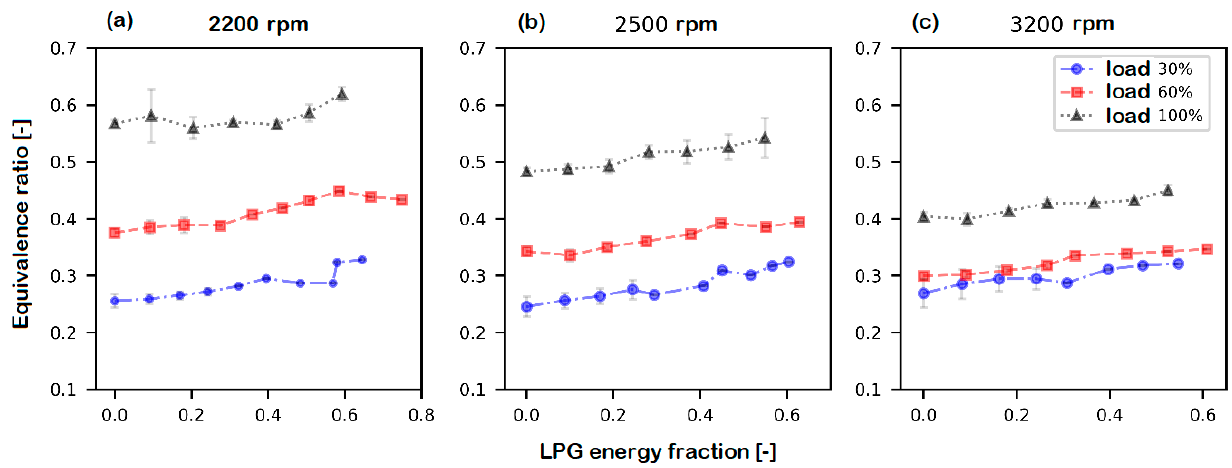
Figure 6. Equivalence ratio v/s LPG energy fraction at ( a ) 2200 rpm, ( b ) 2500 rpm, and ( c ) 3200 rpm. Table 3 highlights the most important findings for PDr, Bfce and diesel fuel substitution for dual Table 3. Most important findings for PDr, Bfce and diesel reduction consumption for dual opera- tion.